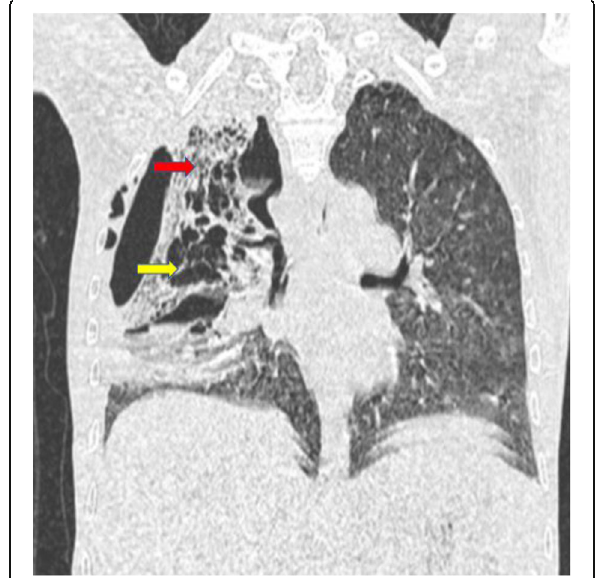
Fig. 3 MDCT with coronal reformation shows collapse of right upper lobe (red arrow) with multiple thick-walled cavities and consolidation of right middle lobe and superior segment of right